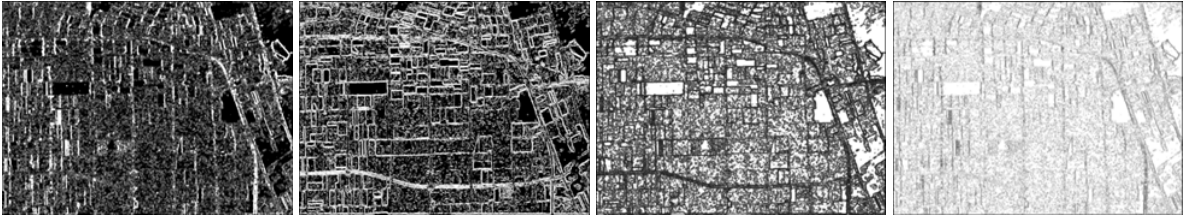
Figure 19. GLCM-based features of T